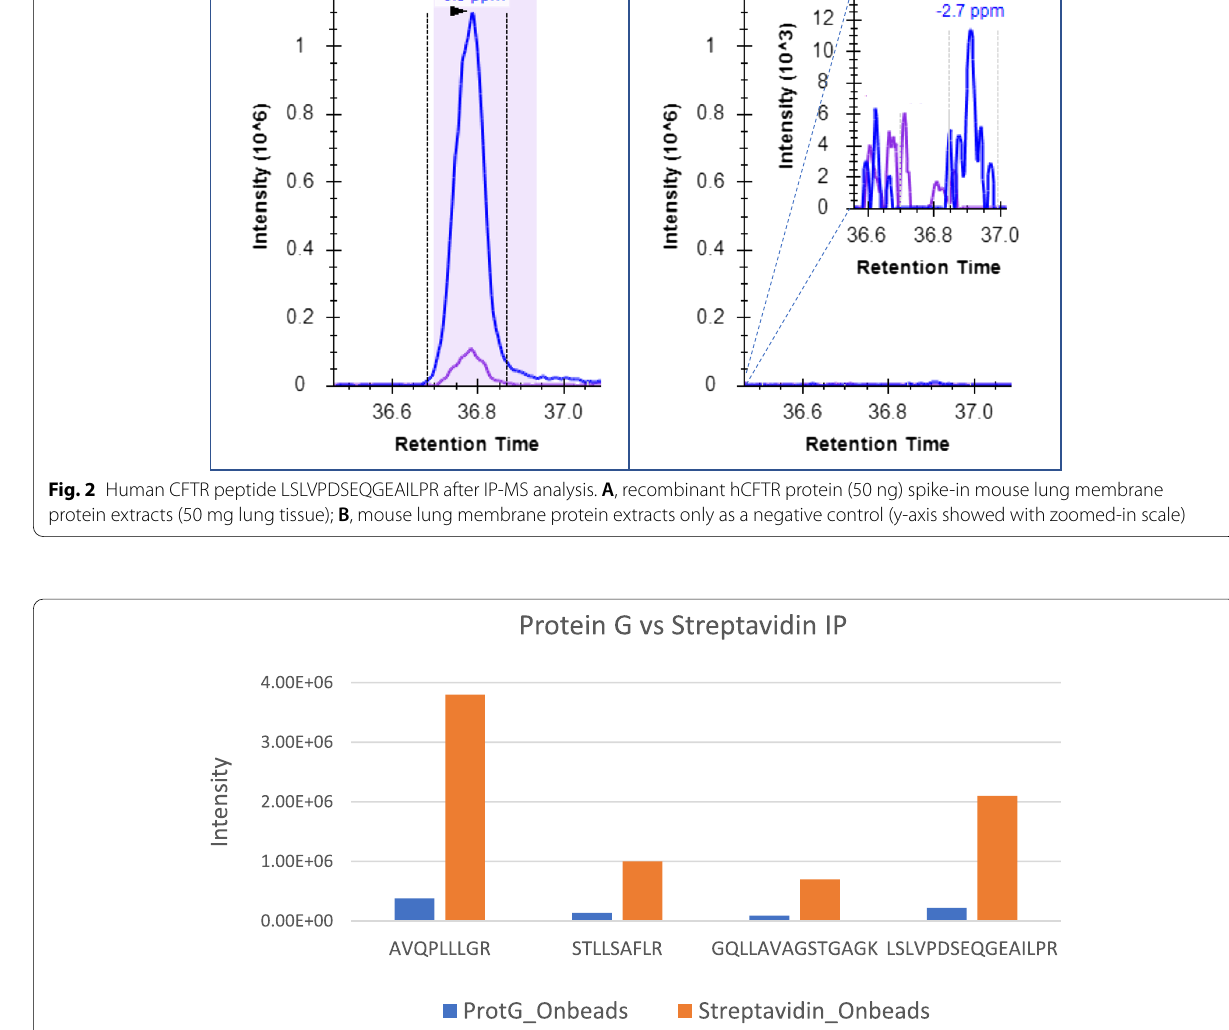
Fig. 3 Comparison of peak intensities of four hCFTR peptides (AVQPLLLGR, STLLSAFLR, GQLLAVAGSTGAGK and LSLVPDSEQGEAILPR) generated by IP using protein G beads vs streptavidin magnetic beads. hCFTR protein (5 ng) spiked in mouse lung membrane protein extracts (50 mg lung tissue) was used as test sample. The data were processed by skyline